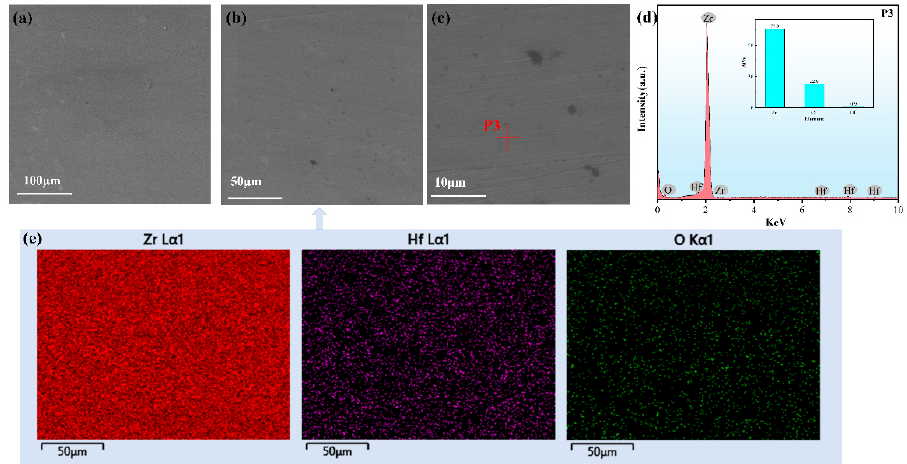
Figure 10. SEM and EDS point sweep after Zr1 corrosion. ( a – c ) SEM micrograph of Zr1 after corrosion;